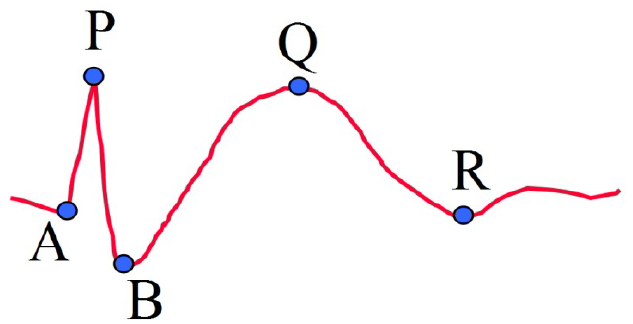
Figure 2. Feature points on the proposed